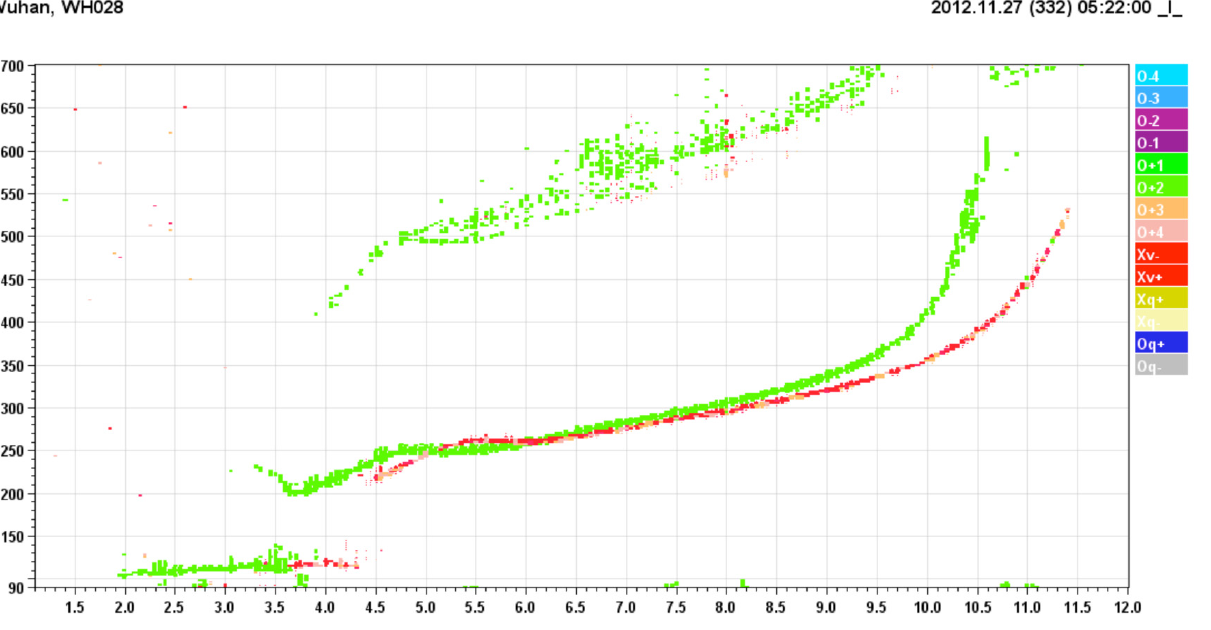
Figure 7. Ionogram of CAS-DIS on November 5, 2012, in station of Wuhan